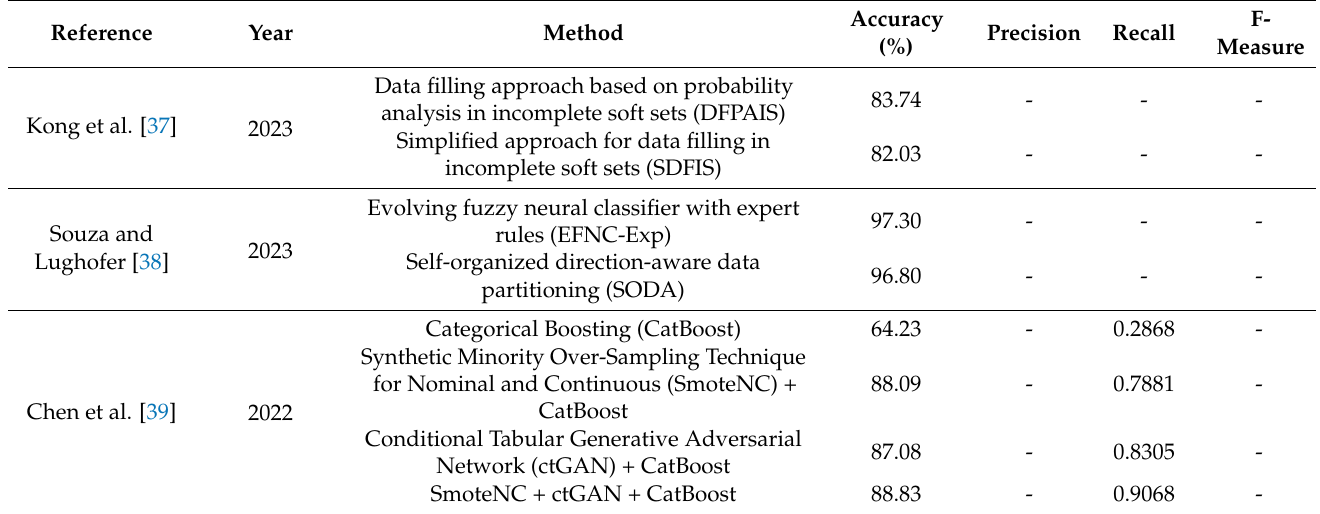
Table 6. Comparison of Balanced K-Star with the state-of-the-art methods on the same